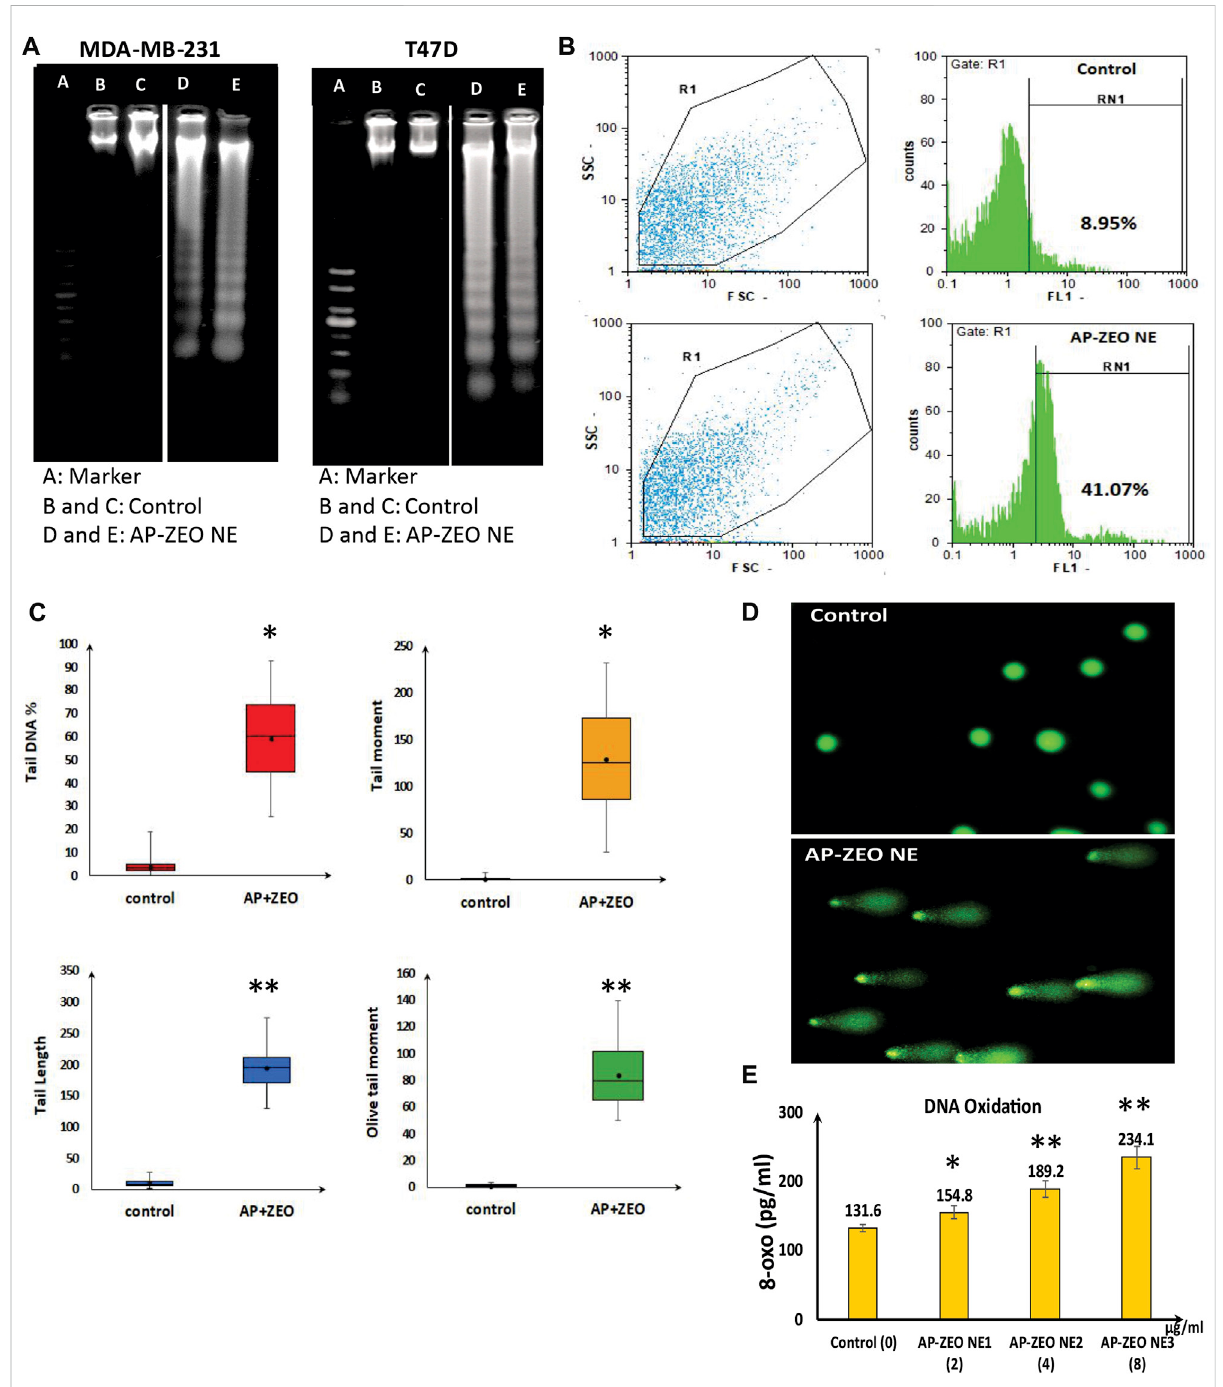
FIGURE 4 AP-ZEONEinducedapoptoticDNAfragmentation (A) analysisonagarosegel(Notethatthis fi gurewascomposedofdifferent(cropped)partsof the same gel, indicated by the dividing lines) and (B) fl ow cytometry analysis by TUNEL assay. AP-ZEONE induced Single-cell DNA damage (C) as visualizedincometassayand (D) analysisperformedonOpenCometsoftware. (E) GenomicDNA8-oxocontentasamarkerofDNAoxidationinAP- ZEONE treated MDA-MB-231 cells and untreated control. ” ** “ and “ * “ indicate the level of statistical signi fi cance p < 0.01 and p < 0.05,